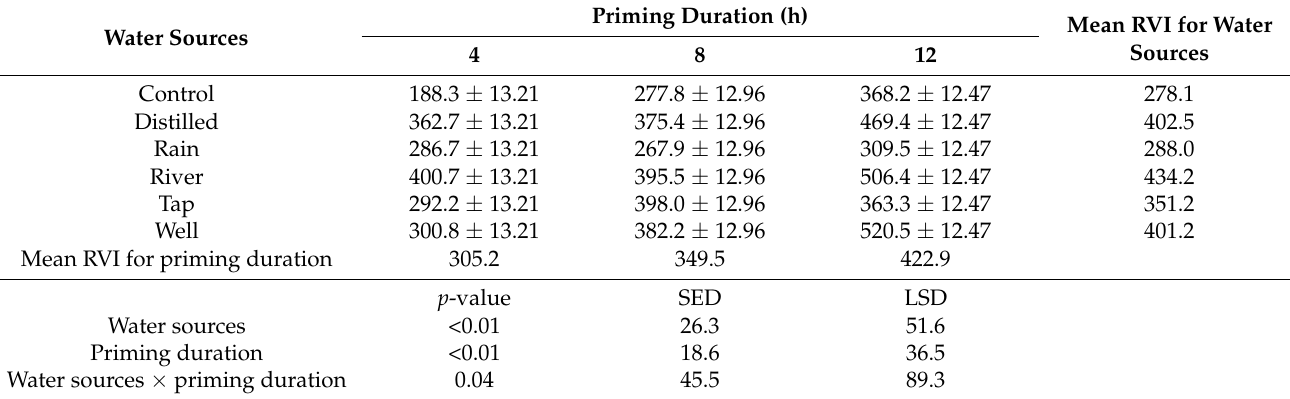
Table 6. Root vigor index of 5 water sources under different priming duration in tepid